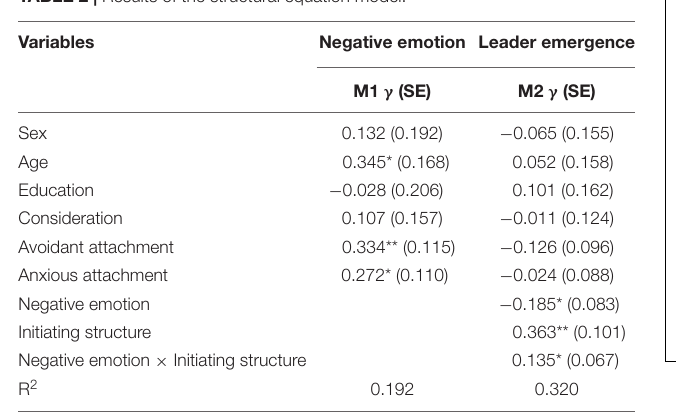
TABLE 2 | Results of the structural equation model.